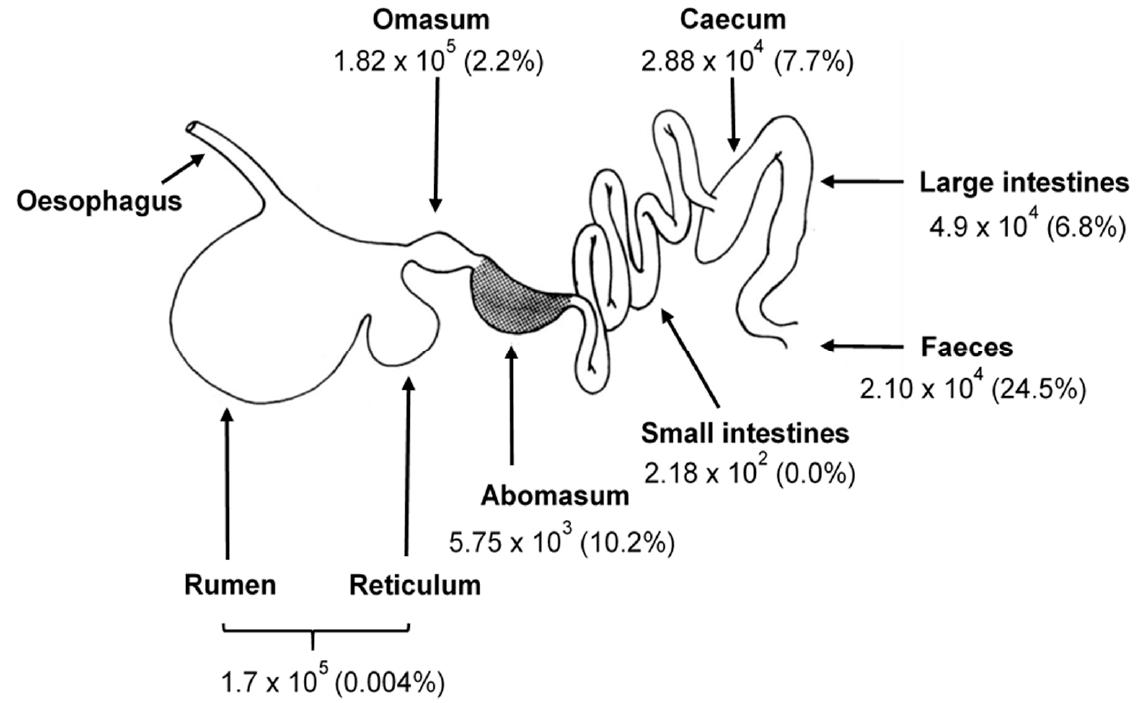
Figure 1. Diagrammatic representation of the ruminant digestive tract. Microbial digestion in the reticulo-rumen precedes gastric digestion which takes place in the abomasum, or true stomach. Values are presented for culturable anaerobic fungal populations (i.e., the number of thallus forming units per gram of dry matter, TFU g · DM − 1 ) in digesta taken from each organ of the digestive tract of grass-silage fed, 8-month-old growing steers. Values in parentheses represent the percentage of the fungal population that survived and were culturable after 7 days of drying digesta or faecal contents at ambient temperature. Data taken from Davies et al. [20].